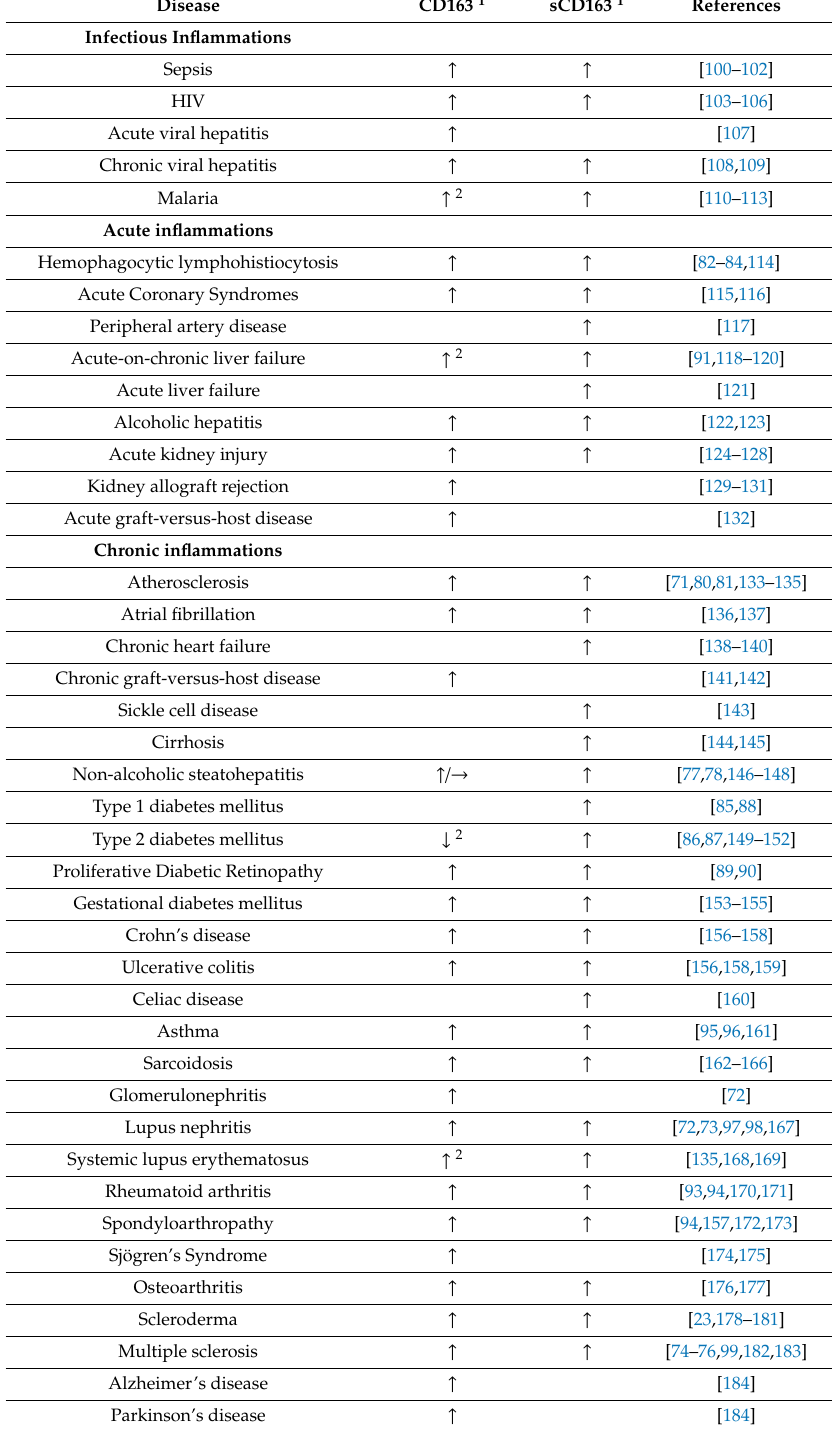
Table 1. Enhanced expression of CD163 + macrophages at site of inflammation and increased soluble CD163 (sCD163) in human inflammatory